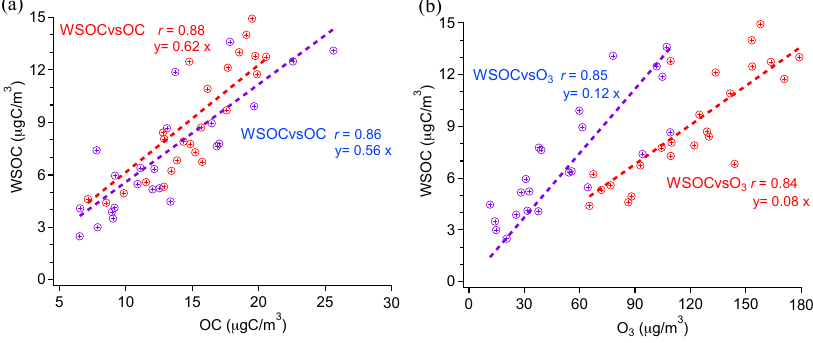
Figure 4. Scatter plots of ( a ) WSOC vs. OC and ( b ) WSOC vs. O 3 (red for daytime, blue for nighttime).